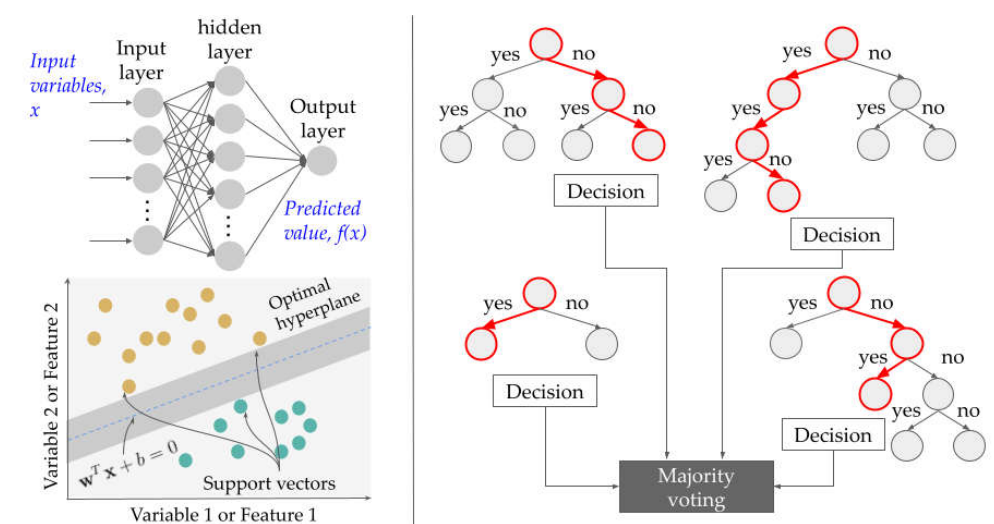
Figure 1. Illustration of a Multilayer perceptron ( top left ), Support Vector Machine with linearly separable data ( bottom left ), and a Random Forest ( right ) with four Decision Tree predictors.